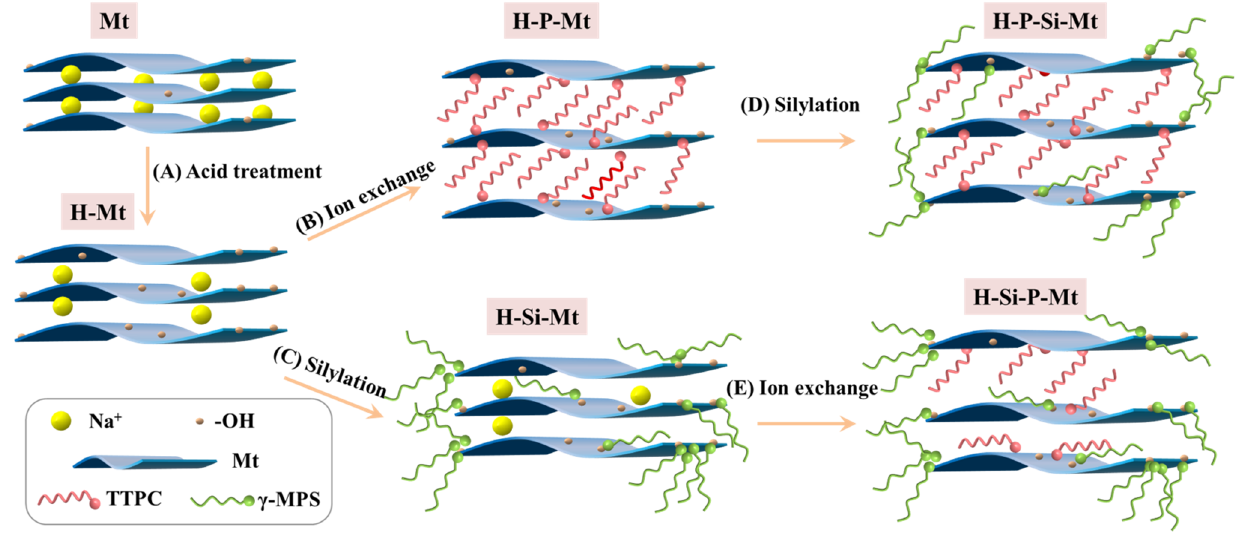
Figure 1. Schematic representation of the acid activation, ion exchange and silylation reactions of Mt samples. ( A ) The acid activation of Mt was performed under the treatment of HCl; ( B ) the TTPC surfactants were intercalated into the interlayer spacing of H-Mt; ( C ) the γ -MPS molecules were grafted onto the exterior surfaces and / or the broken edges of the H-Mt; ( D ) the H-P-Mt was modified with γ -MPS molecules to obtain the H-P-Si-Mt; (E) the H-Si-Mt was intercalated with TTPC surfactants to obtain the H-Si-P-Mt